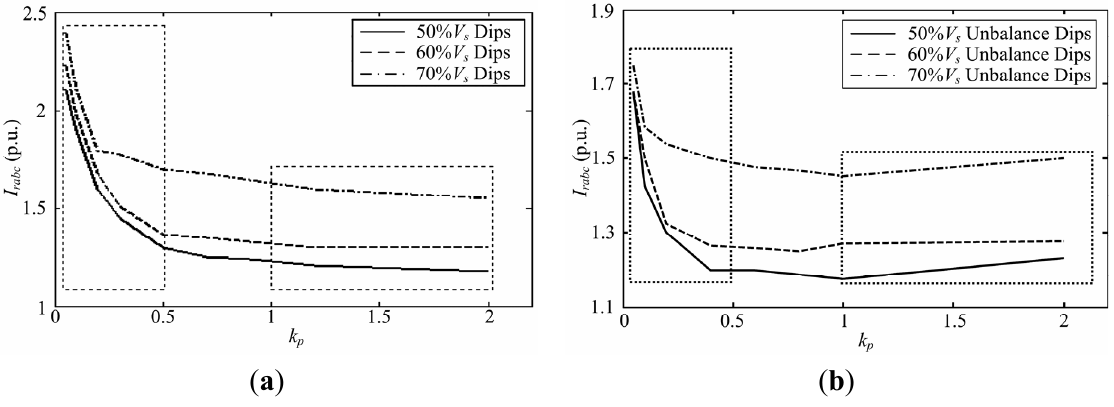
on the peak of rotor current. ( a ) three-phase-to-ground fault; Figure 17. The effect of k p ( b ) phase-phase-to-ground